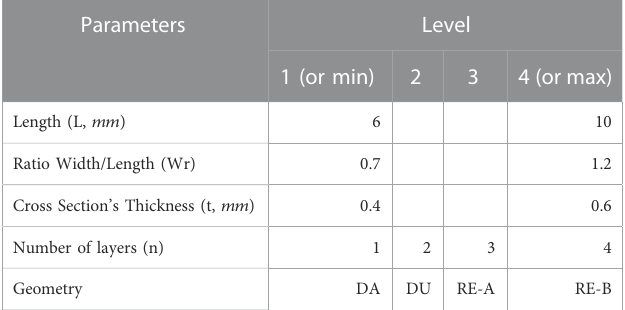
TABLE 1 Parameters and levels of the design of experiment.